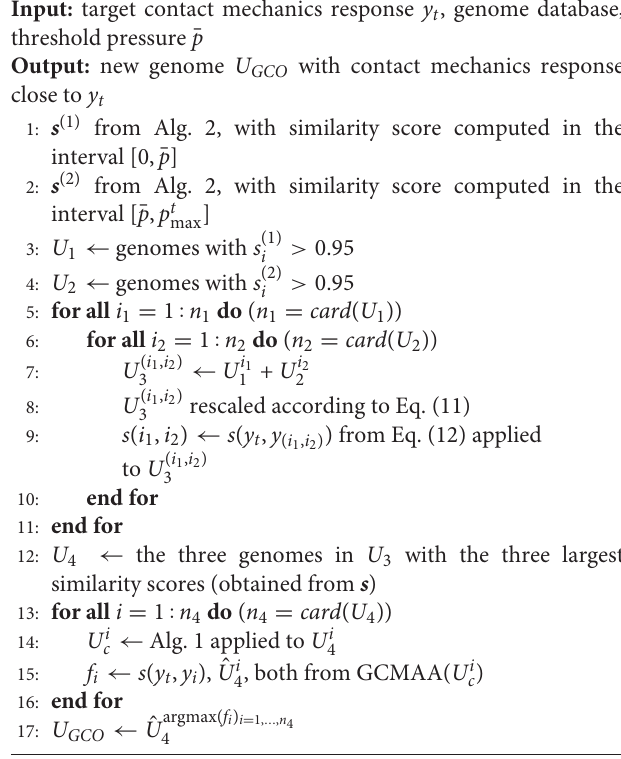
Algorithm 4 | Genome Cross-Over